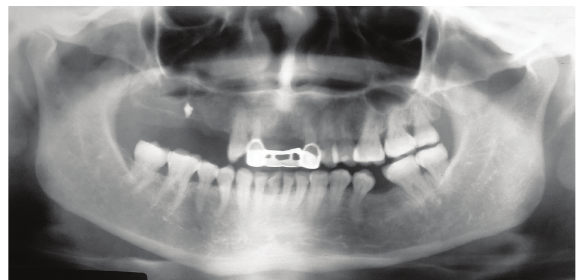
Figure 1: Panoramic X-ray. Notice the presence of a right maxillary radiopacity and the absence of teeth 1, 2, 3, 4, and 5, all with ade- quate bone healing except the 3 area.